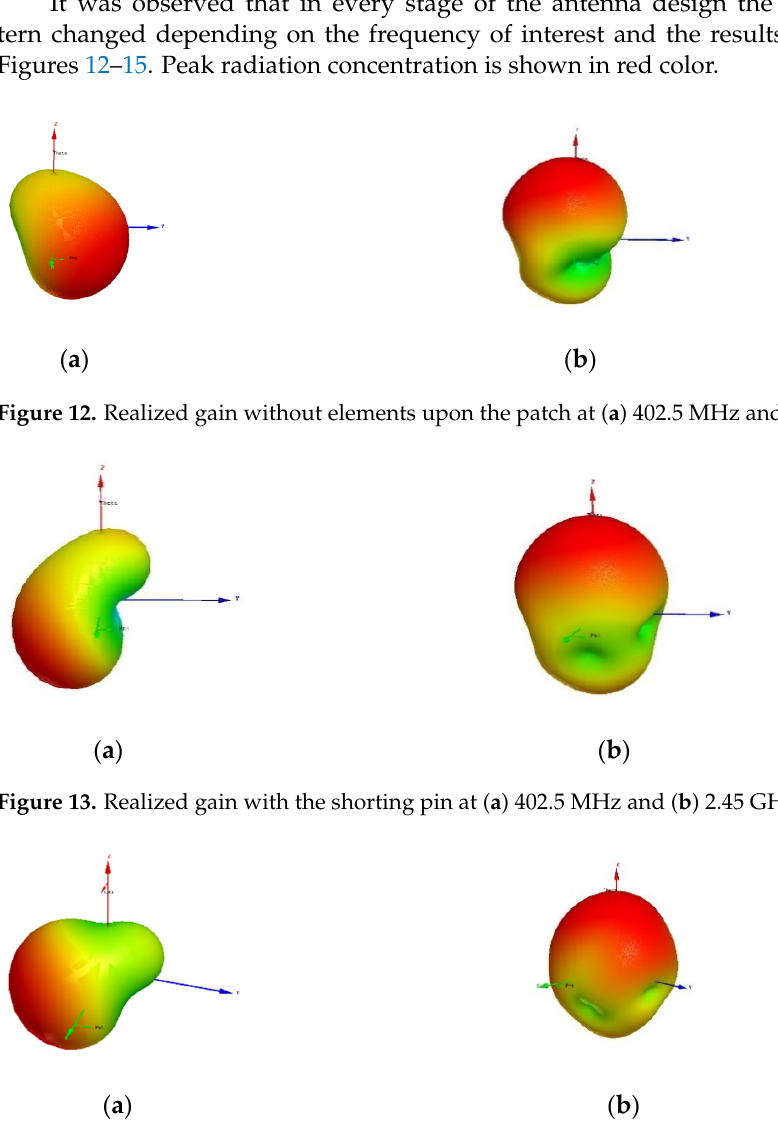
Figure 14. Realized gain of with the shorting pin and one of the U-slots upon the patch at ( a ) 402.5 MHz and ( b ) 2.45 GHz.